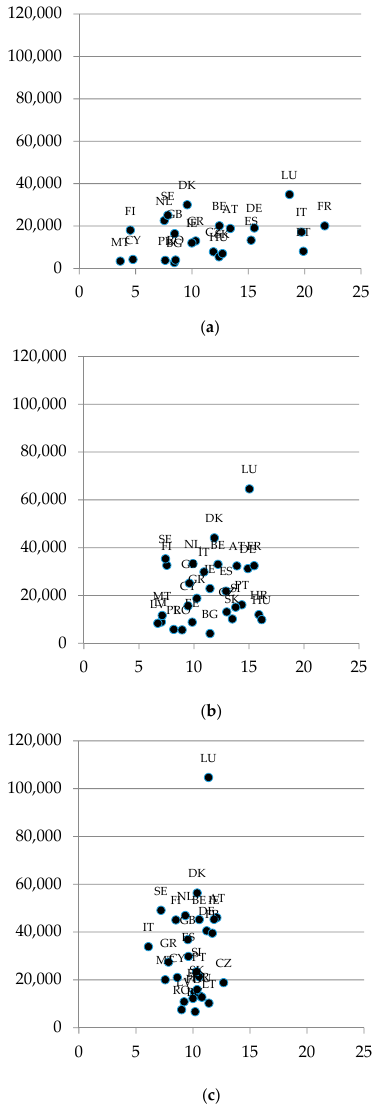
Figure 2. Per-capita income and alcohol consumption in the EU-28 in ( a ) 1970, ( b ) 1990) and ( c ) 2010. Note: Real Gross Domestic Product (GDP) per capita in US dollars (USD) is on the Y-axis, alcohol consumptions (in liters of pure alcohol)—on the X-axis.